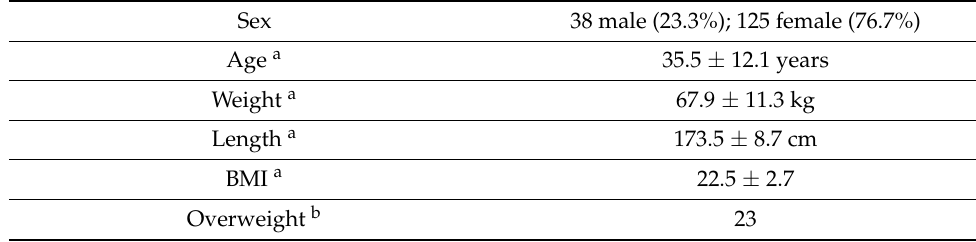
Table 1. Characteristics of study subjects (N = 163).